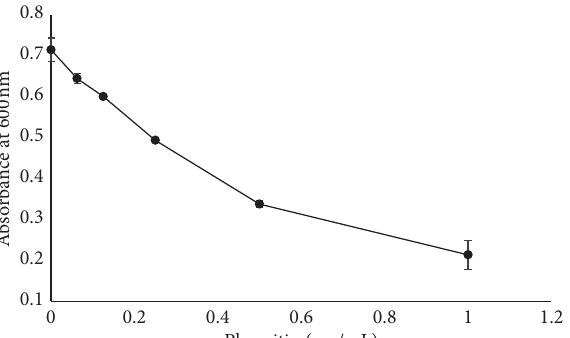
Figure 6: Minimum inhibitory concentration assay. The ability of phosvitin to inhibit the growth of M. luteus was assessed in the absence of added calcium by measuring turbidity at an absorbance of 600nm. Error bars reflect the standard deviation associated with the average of two measurements. There was no visible growth of M. luteus at either 0.5 mg/mL phosvitin or at 1mg/mL phosvitin. When linear regression analysis was performed on the data at 0.13, 0.25, and 0.5mg/mL phosvitin (trend line not shown), the R 2 for the linear regression was 0.9906, and the equation for the line was y �− 0.7408 x